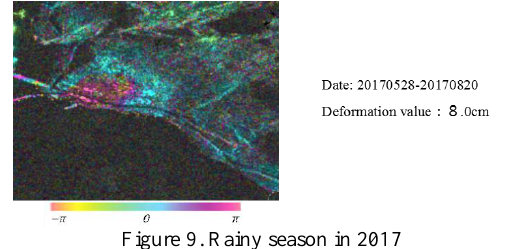
Figure 9. Rainy season in 2017